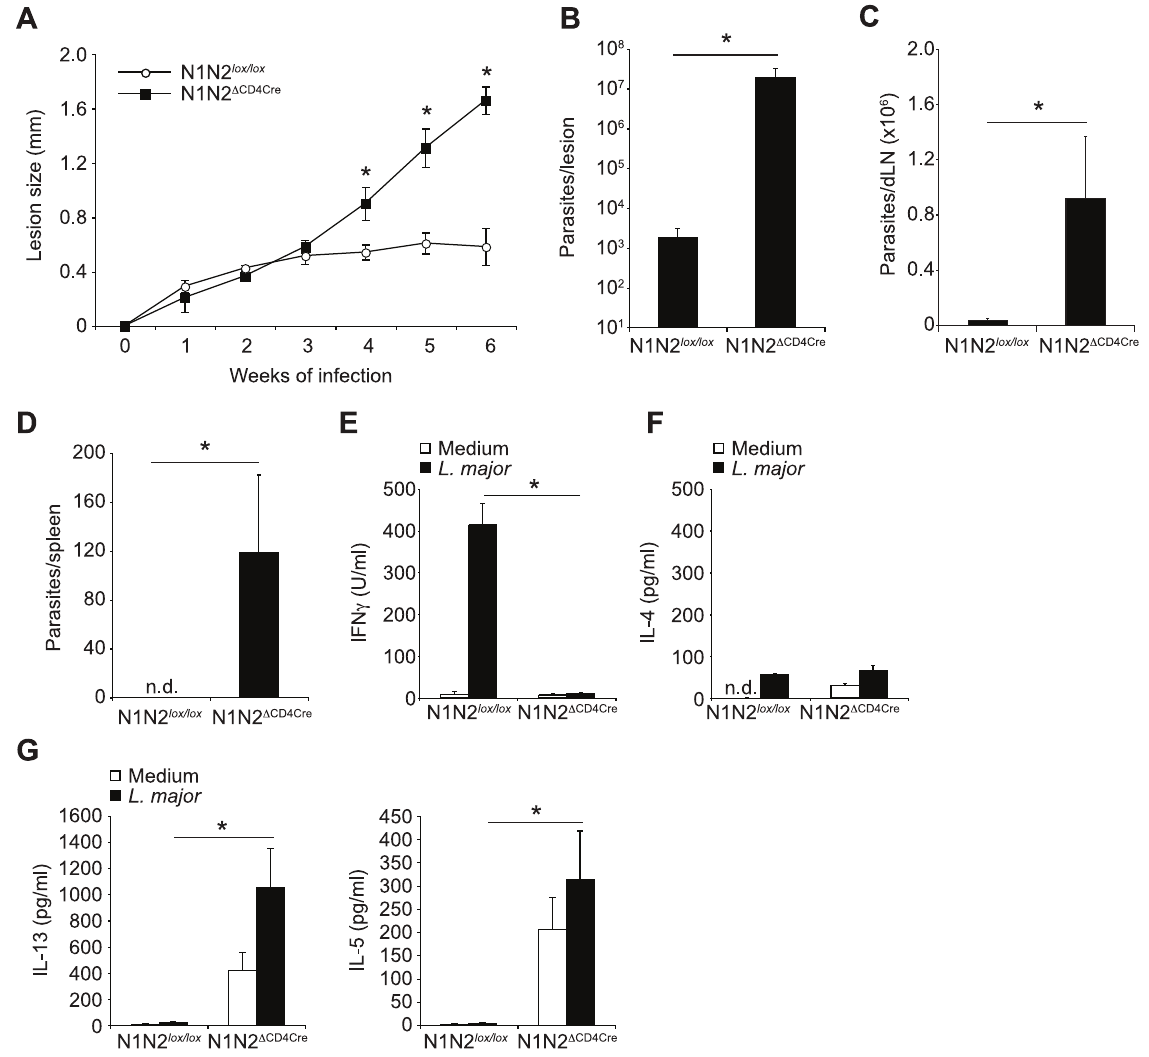
Figure 1. N1N2 D CD4Cre mice on the C57BL/6 L.major resistant background are susceptible to infection. (A) N1N2 D CD4Cre and control N1N2 lox/lox mice were infected with 3 6 10 6 L. major promastigotes and lesion size measured weekly. Dots represent group mean of lesion size 6 SEM. (B, C) Six weeks after infection, parasite load was assessed by LDA in footpads (B), dLN (C) and spleen (D). Histograms represent the mean number of parasite 6 SEM (n $ 3 mice per group). (E–G) IFN c (E), IL-4 (F), IL-13 and IL-5 (G) secretion was quantified in supernatants of draining lymph node cells restimulated or not with UV-irradiated L. major 6 weeks after infection. Mean cytokine secretion 6 SEM are given (n $ 3 mice per group). Data are representative of at least 3 individual experiments. n.d. not-detectable. * p-value , 0.05 versus control